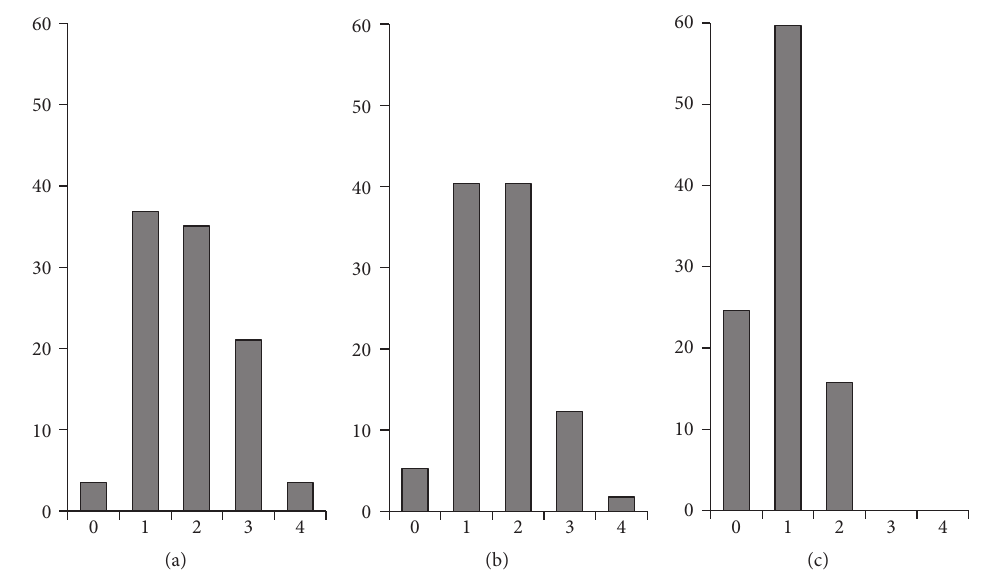
Figure 4: Frequency diagrams showing the percentage of matching model results with original Grime’s classification. On the horizontal axis is the deviation between positions in the original 𝐶𝑆𝑅 classification and given by the model ((a), Hodgson et al.’s model; (b), Pierce et al.’s model; (c), our model). The percentage of species is presented on the vertical